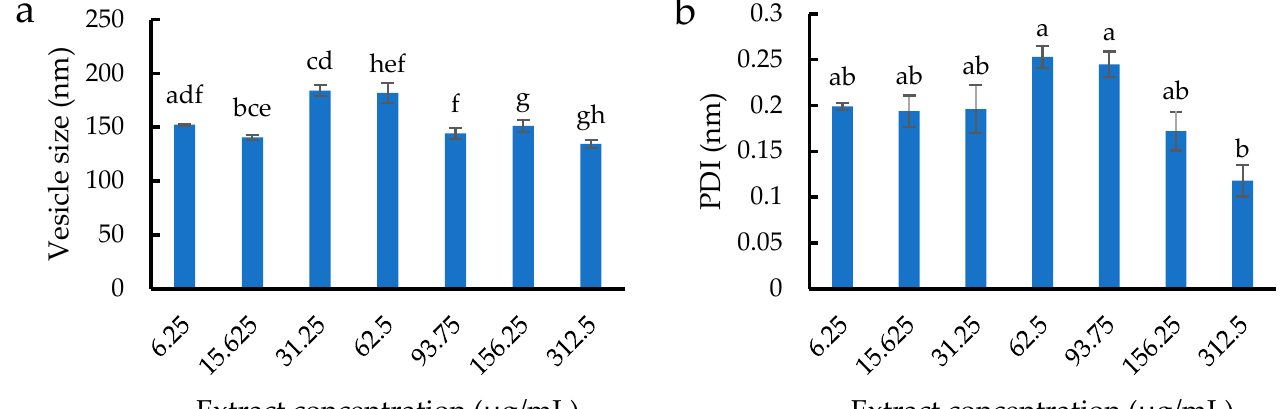
Figure 2. ( a ) Vesicle size, ( b ) size distribution, and ( c ) zeta potential of blank ethosomes treated by different sonication times. Different letters above the error bars indicate significant differences at the 0.05 level (ANOVA and post hoc test).